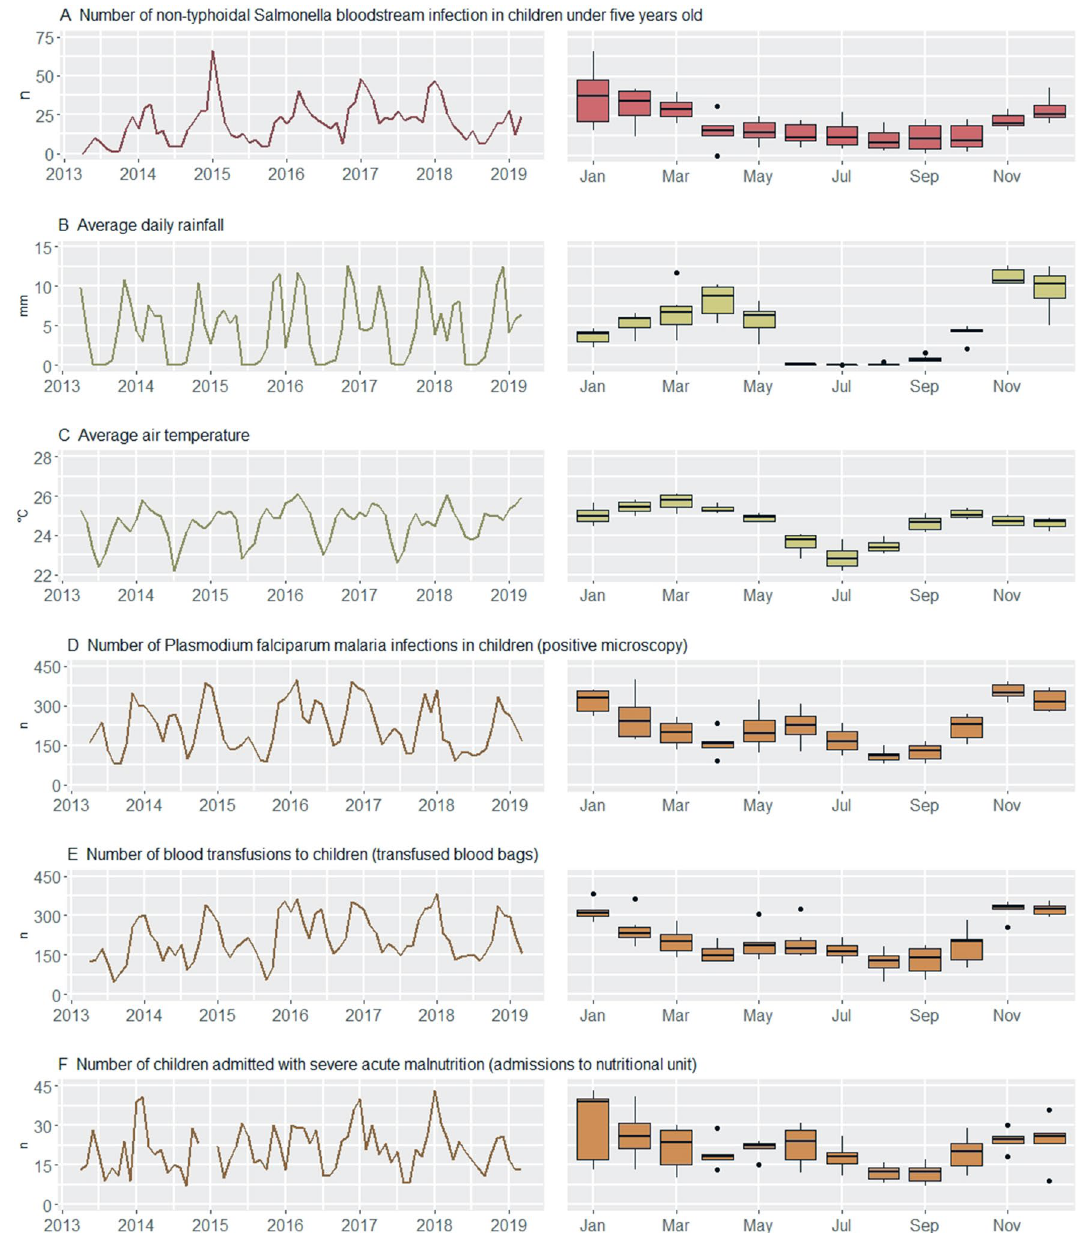
Figure 2. Timeseries (left) and seasonality (right) plots of non-typhoidal Salmonella (NTS) bloodstream infections in young children (red), of environment- (green) and host-associated (brown) factors for NTS bloodstream infection. In both plots, the NTS infections and host-associated factors are expressed as number of cases per month, and the environment-associated factors as the average of the daily rainfall and average of the air temperature per month. The seasonality plot is based on the full data